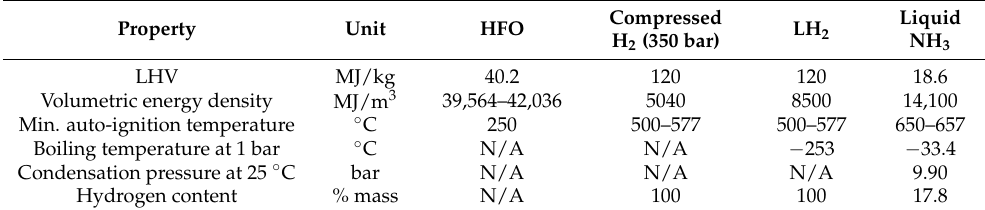
Table 1. Fuel properties of HFO, H 2 , and NH 3